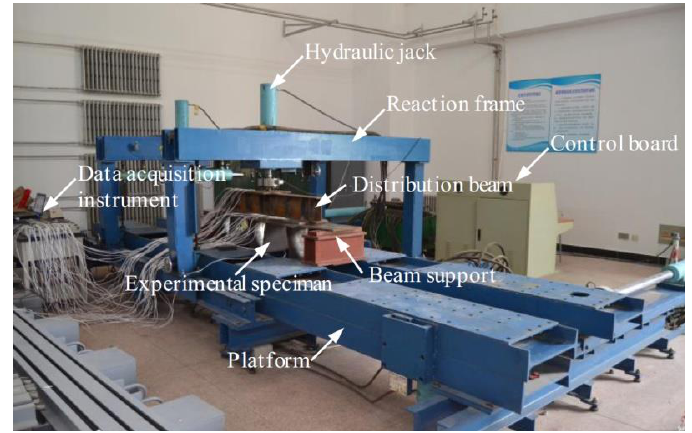
Figure 9. Static-load experimental